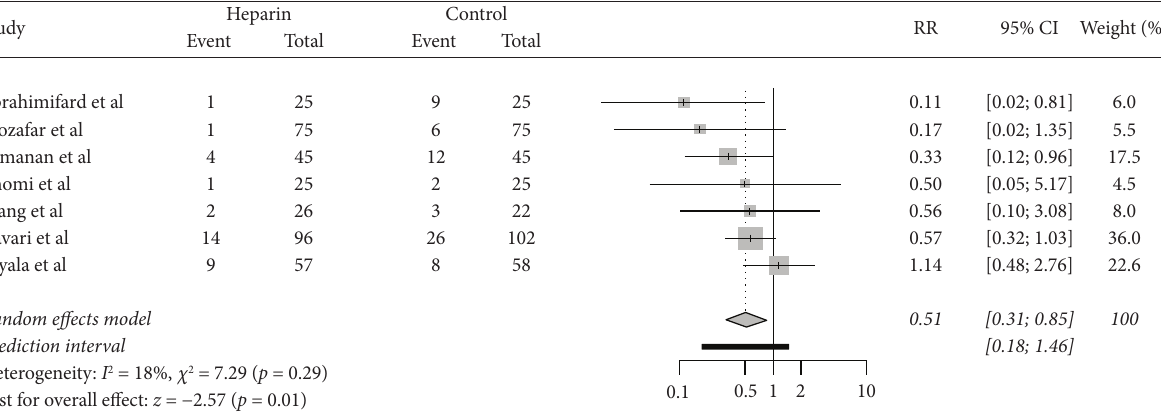
Figure 2: Forest plot suggesting benefit from intraoperative heparin use on the risk of loss of AVF